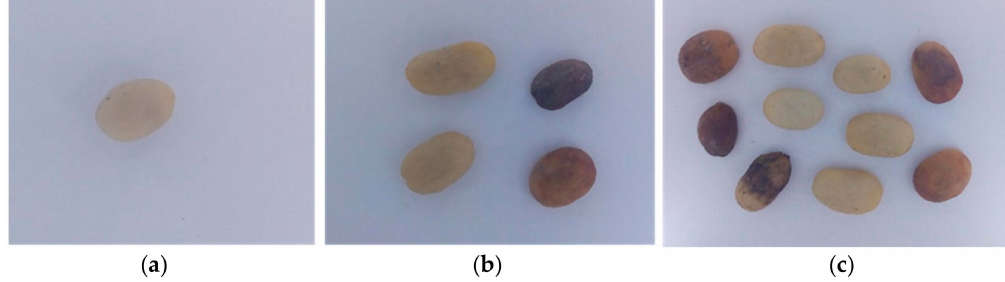
Figure 5. Examples of images acquired for: ( a ) one co ff ee bean, ( b ) four co ff ee beans and ( c ) ten co ff ee